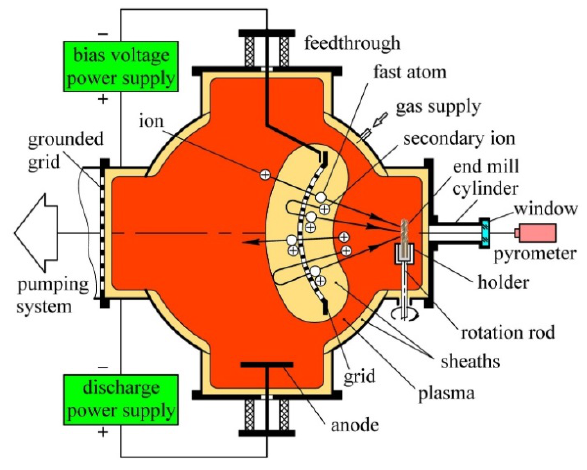
Fig. 3 . Schematic of the beam formation by a